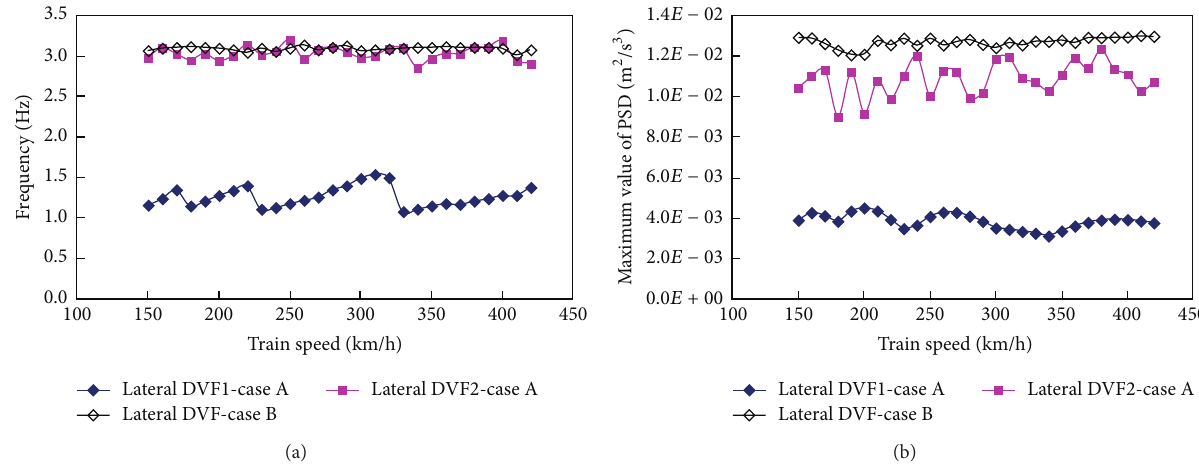
Figure 10: Trailer carbody lateral acceleration with respect to train speed. (a) DVF. (b) Maximum value of